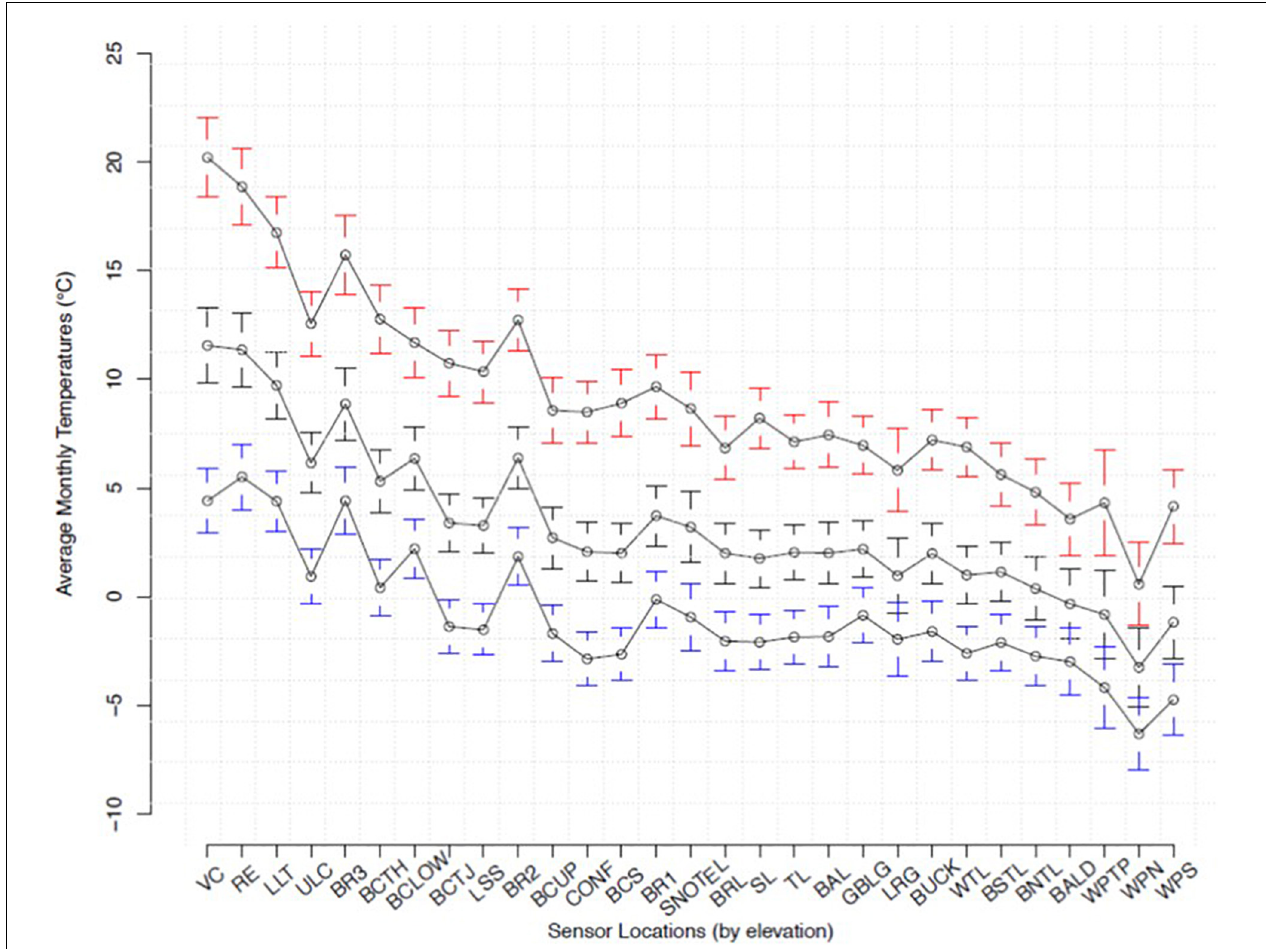
FIGURE 10 | Average monthly T mean (black), T min (blue), and T max (red) of ESN sensors. Plot shows sensors ordered by elevation, from the lowest sensor (VC) on left to highest sensor (WPS) on